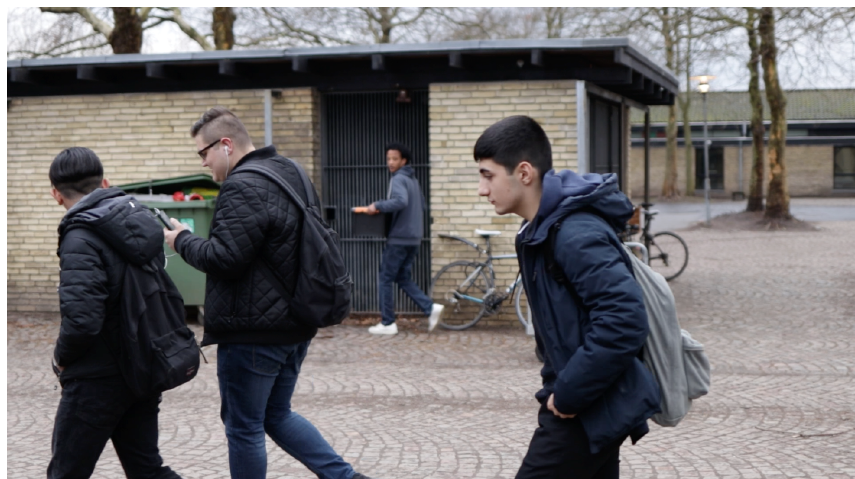
Figure 7. A young resident of the former retirement home works as a cleaner at a nearby school. School lets out as he begins his work. April 2017.